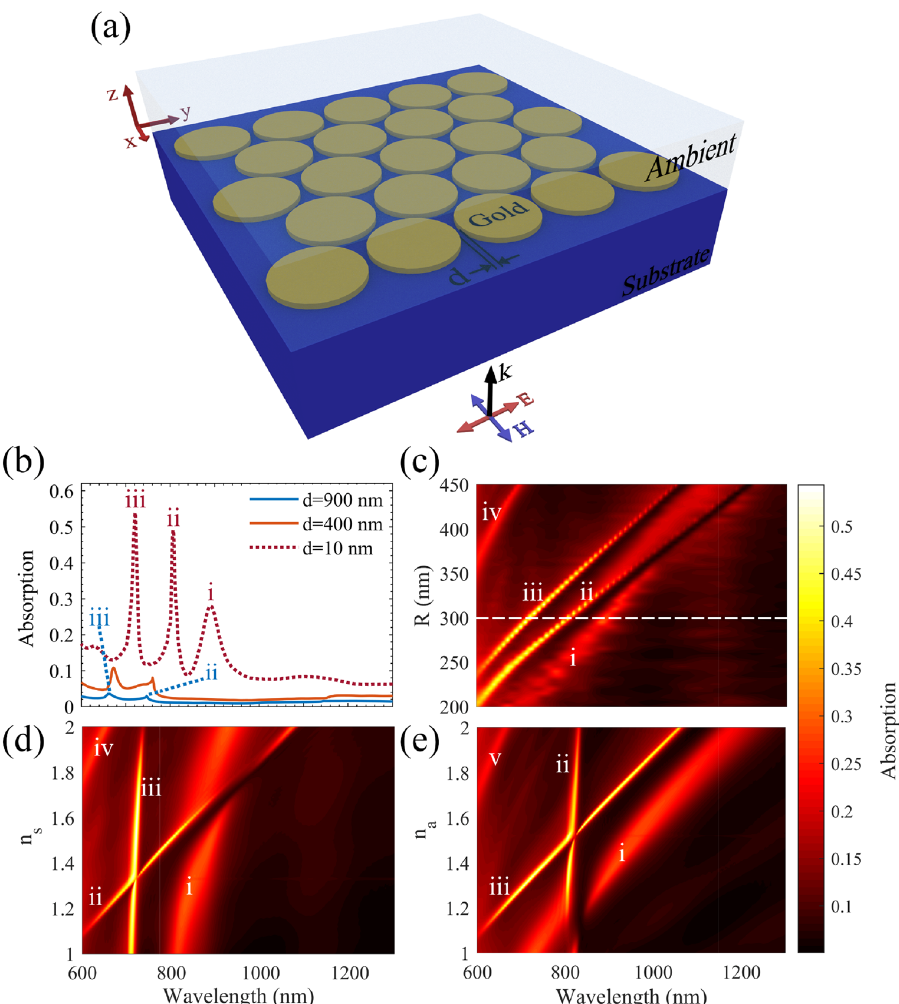
Figure 3. ( a ) 3D scheme of the proposed gold disc array. ( b ) Absorption spectra of the propsoed structure with d = 900 nm, 400 nm, and 10 nm, when R = 300 nm, n a = 1.33, and n s = 1.52. ( c , d ) The calculated absorption profile for closed pack gold disc array of d = 10 nm, versus: ( c ) R and λ 0 ( n a = 1.33 and n s = 1.52), ( d ) n s and λ 0 ( n a = 1.33 and R = 300 nm) and ( e ) n a and λ 0 ( n s = 1.52 and R = 300